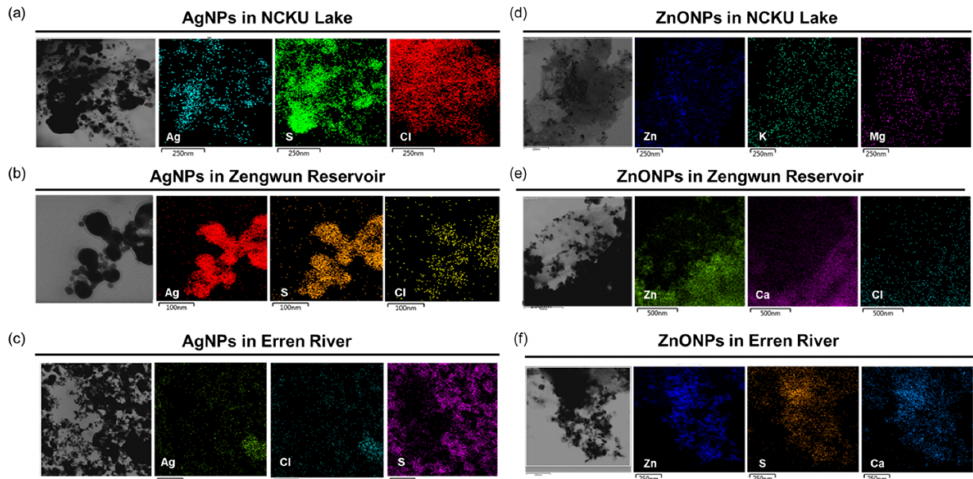
Figure 3. Elemental mapping images of AgNPs and ZnONPs in natural water. ( a – c ) Elemental mapping analysis of Ag spiked in NCKU Lake, Erren River, and Zengwun Reservoir water. ( d – f ) Elemental detection of ZnONPs spiked in natural water. AgNPs, silver nanoparticles; ZnONPs, zinc oxide nanoparticles; S, sulfur; Cl, chlorine; Mg, magnesium; K, potassium; Ca, calcium.